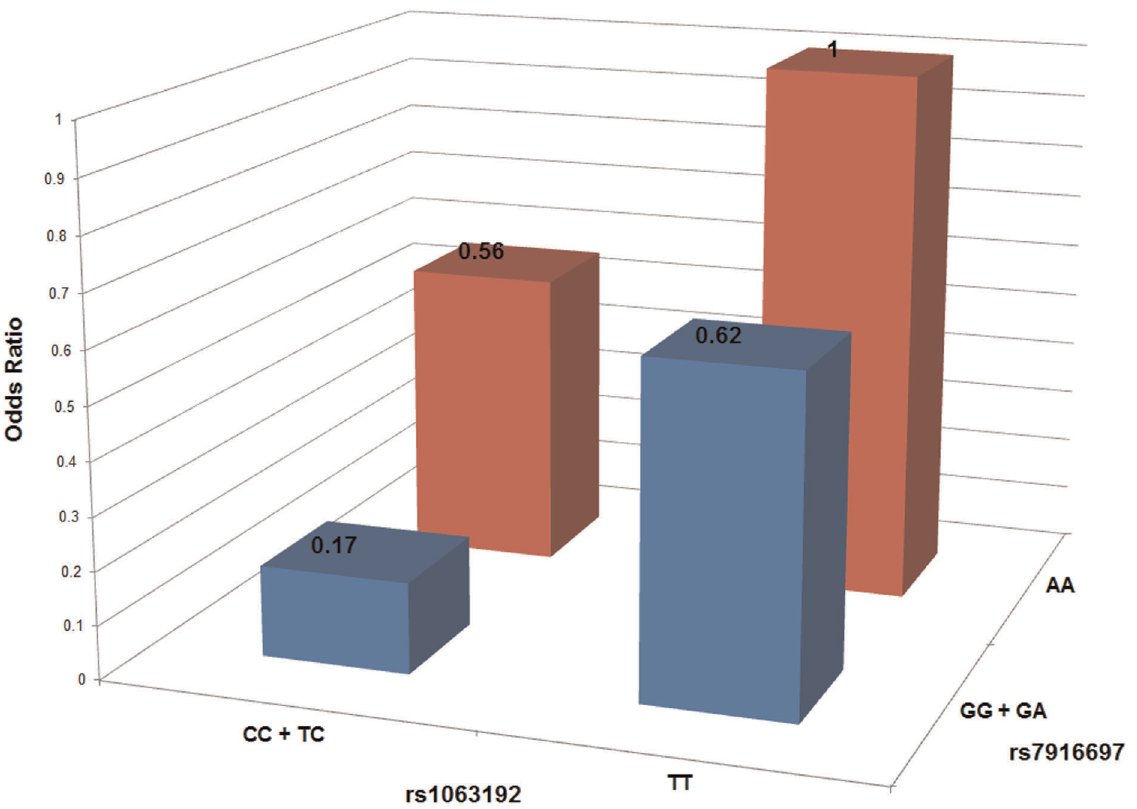
Figure 1. Interaction between rs1063192 and rs7916697. Logistic regression modeling showed that the joint effects between rs1063192 and rs7916697 were interactive ( P -interaction=2.80E 2 5).The joint odds ratios were estimated for combinations of protective genotypes of rs1063192 (in the dominant model) or rs7916697 (in the dominant model) compared with the combination of both risk genotypes (homozygous major alleles for both markers).